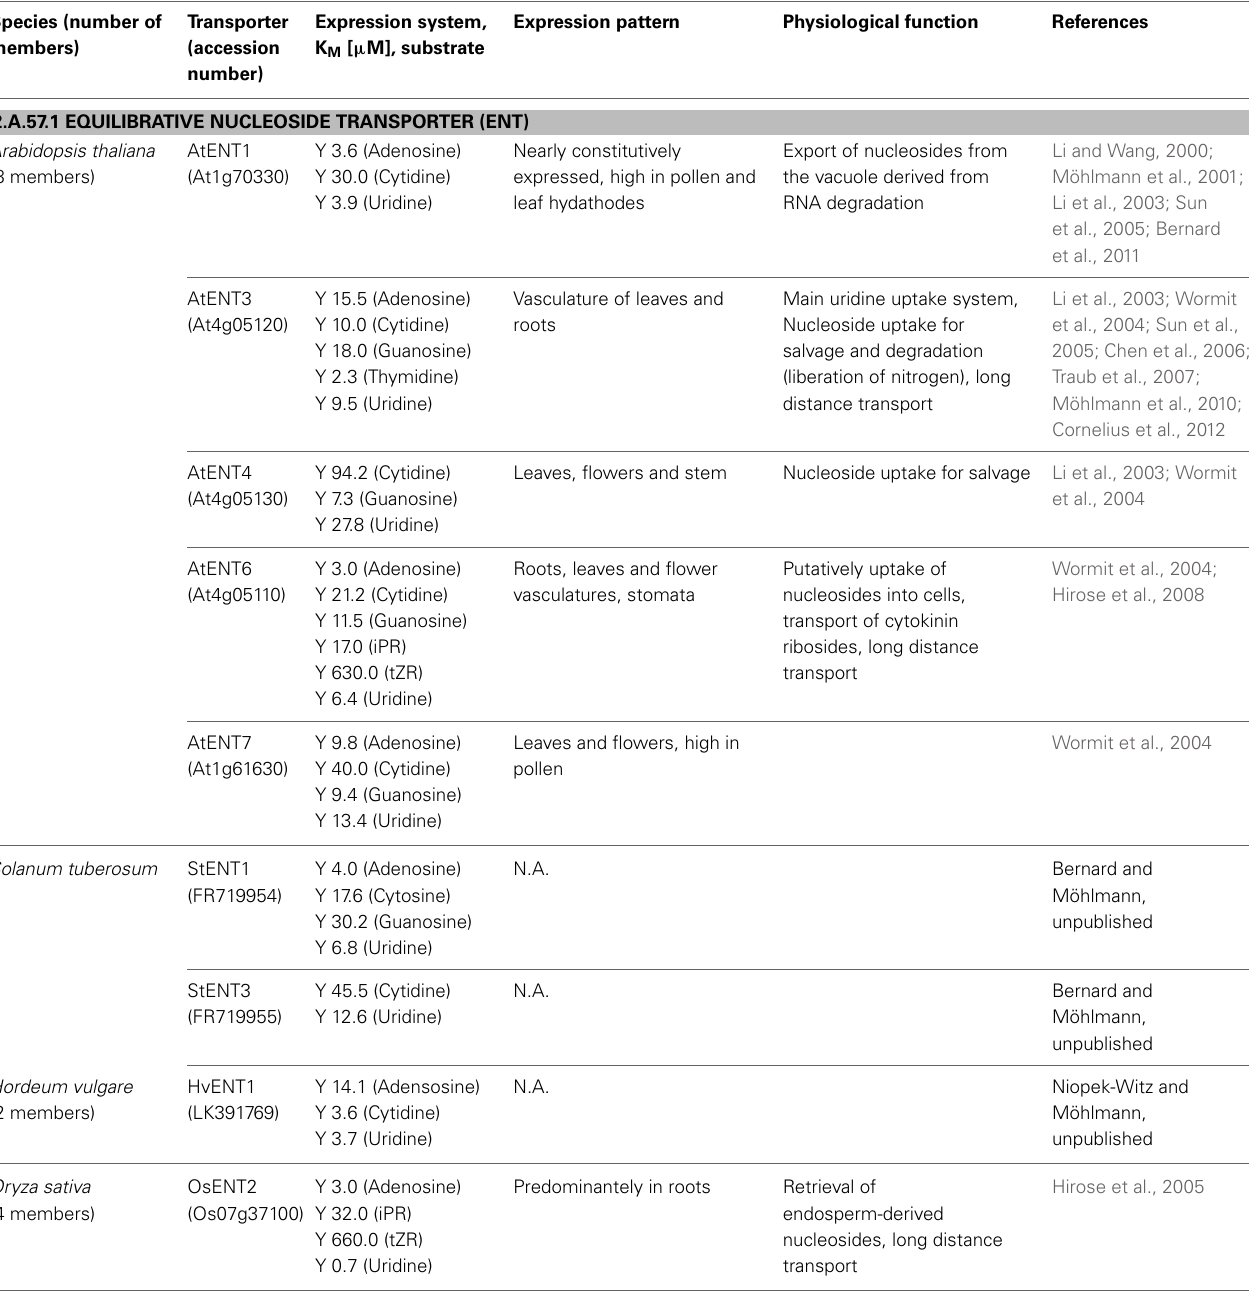
Table 1 | Nucleoside transporters of the ENT family. Species (number of